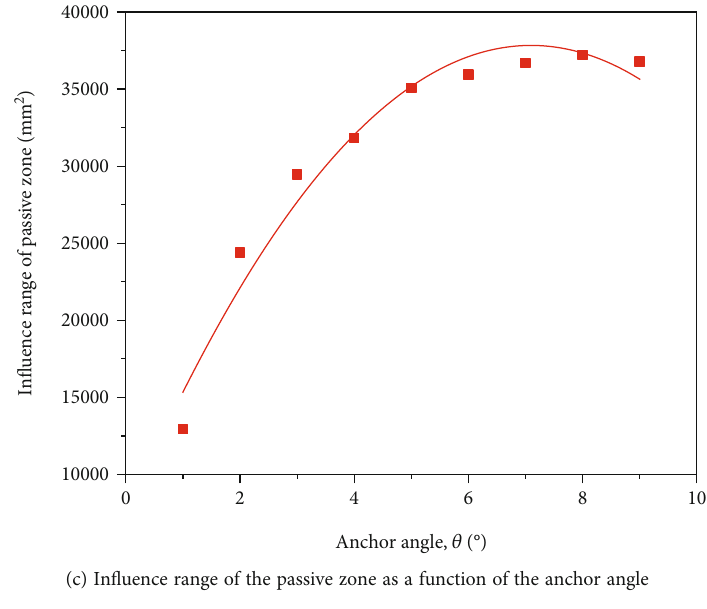
(c) In fl uence range of the passive zone as a function of the anchor angle Figure 13: In fl uence range as a function of the anchor